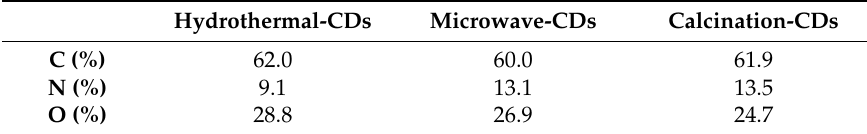
Table 2. Atomic composition (%) obtained by XPS for the three di ff erent